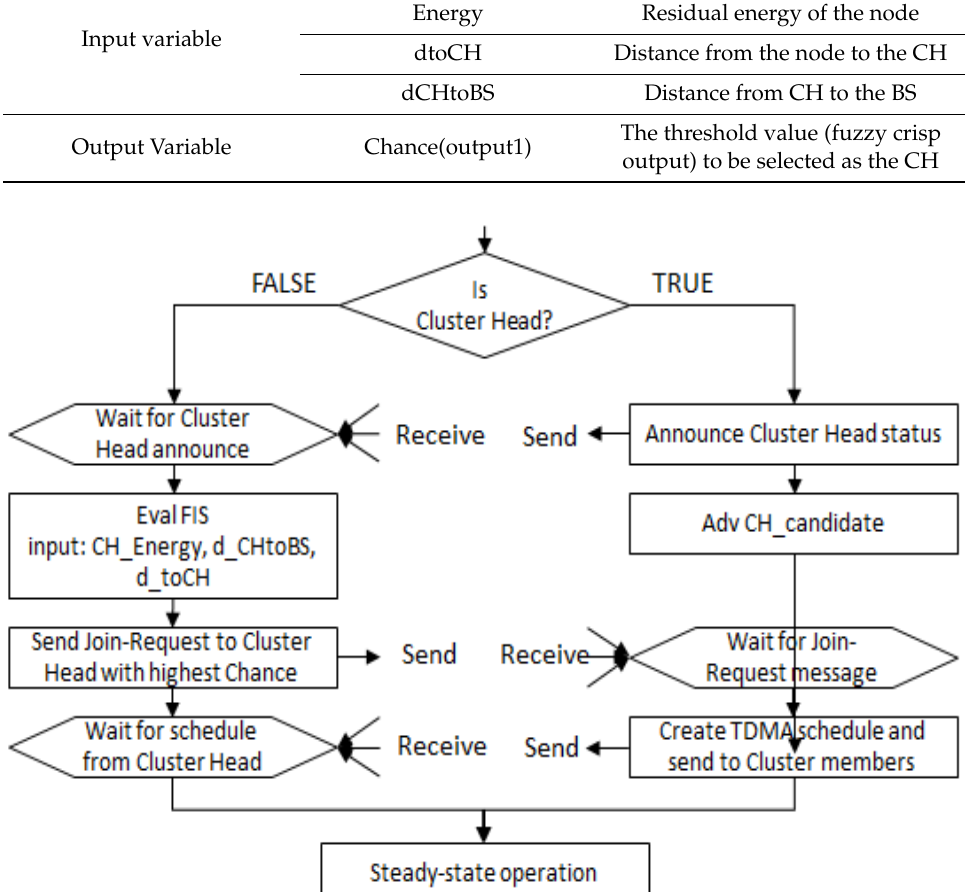
Figure 9. Membership functions of inputs and output in second FIS. Table 3. FIS input and output variables during cluster formation.